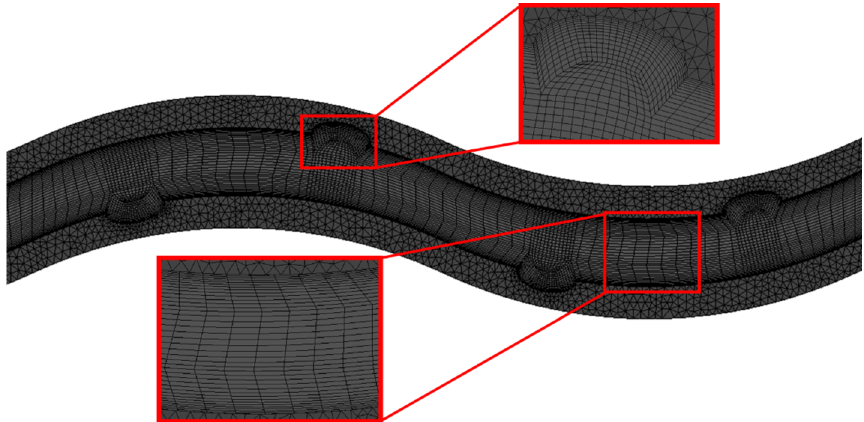
Figure 3. Example of a computational grid system on one cycle of wavy channel.